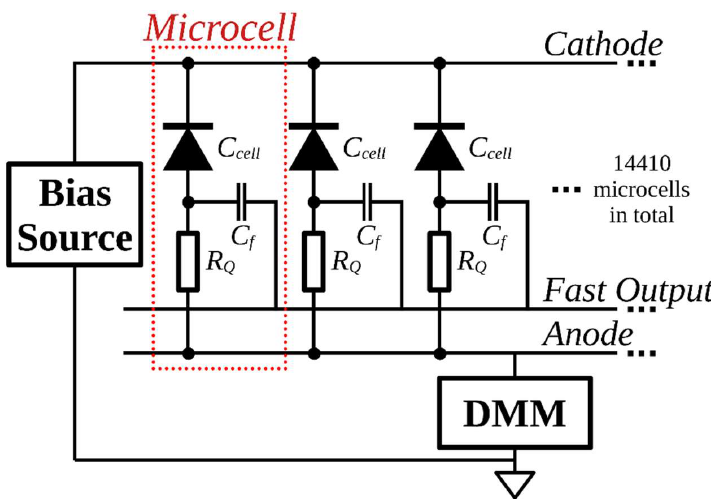
Figure 2. A schematic diagram showing three microcells in a representative Onsemi SiPM. The dia- gram also shows how these are connected the source of the bias voltage and a digital multimeter that is used to measure the bias current needed to sustain the bias